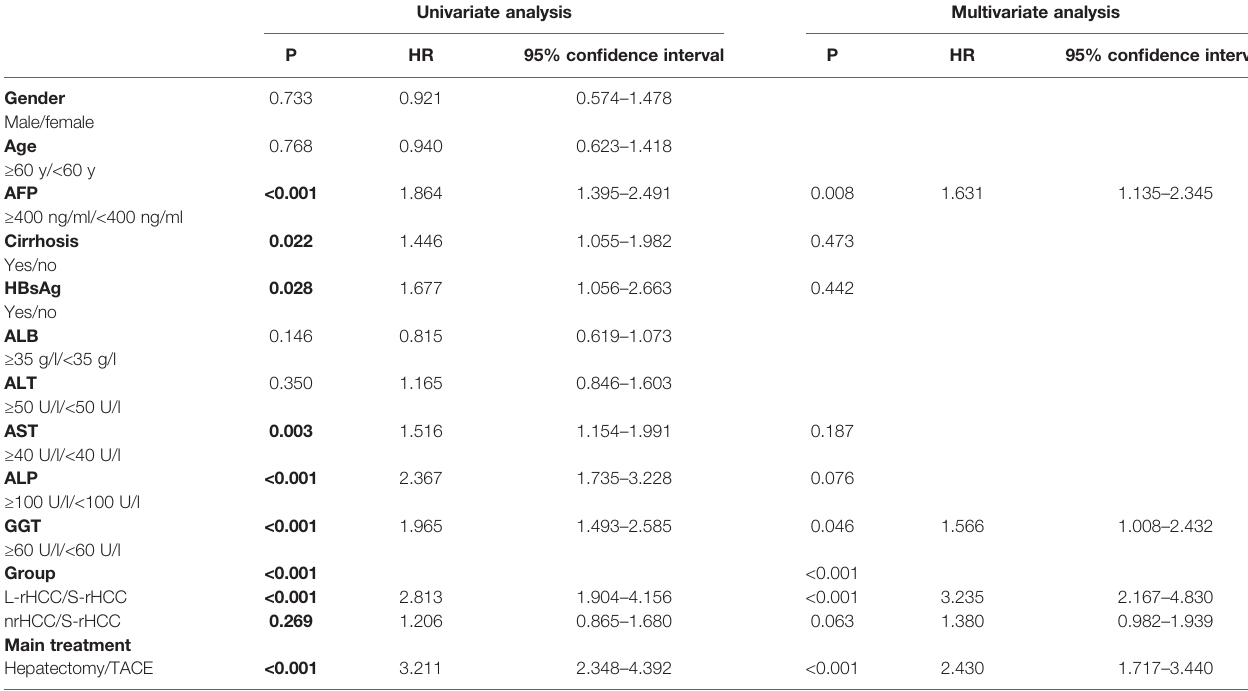
TABLE 4 | Univariate and multivariate analyses of overall survival among S-rHCC, L-rHCC, and nrHCC in the BCLC 0/A